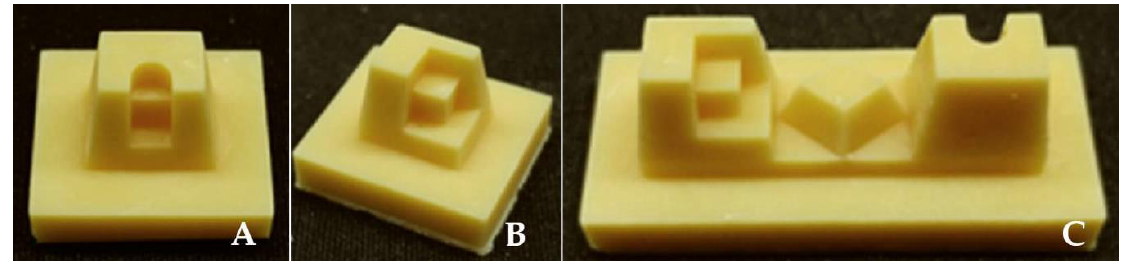
Figure1. Referencemodelsfabricatedby3Dprinter: ( A )inlaymodel, ( B )onlaymodel, ( C Figure 1. Reference models fabricated by 3D printer: ( A ) inlay model, ( B ) onlay model, ( C ) bridge model.